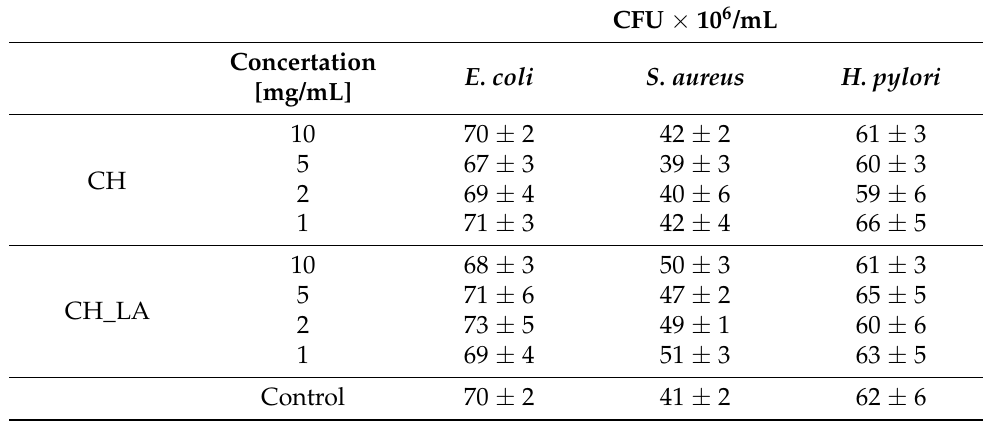
Table 1. Antibacterial properties of CH and CH_LA determined by agar impregnation